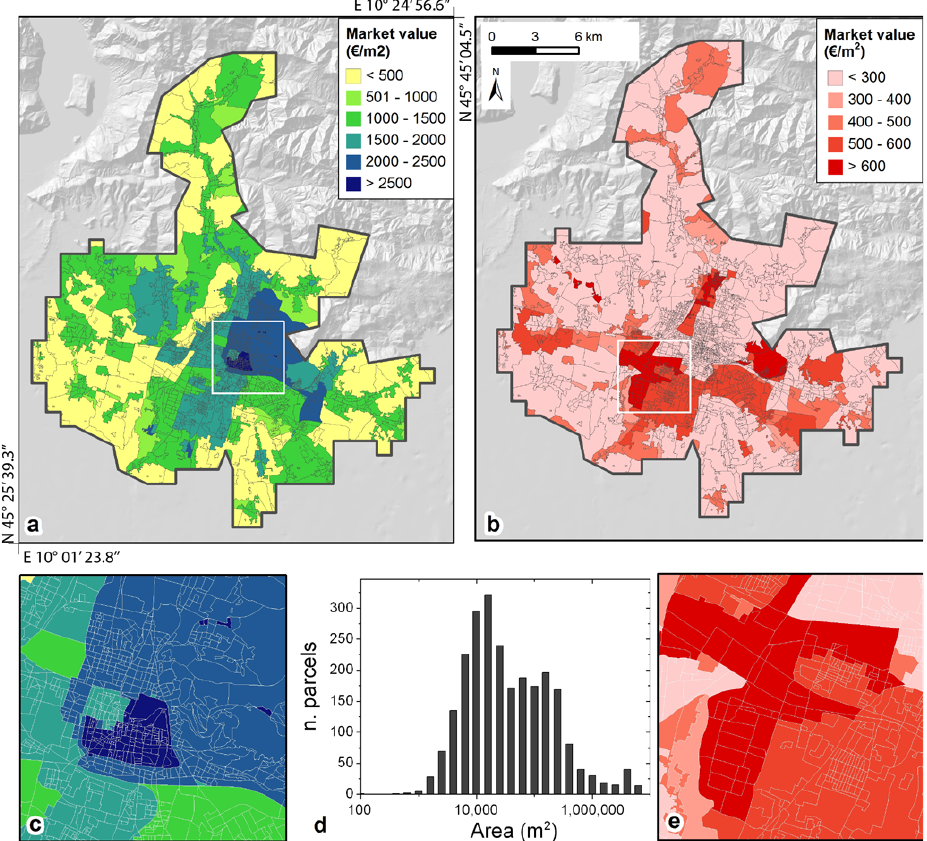
Fig. 4. Economic value in eurom − 2 , W , for residential buildings (a, c) , non-residential buildings (b, e) . Frequency of surface of census parcels in the study area (d)